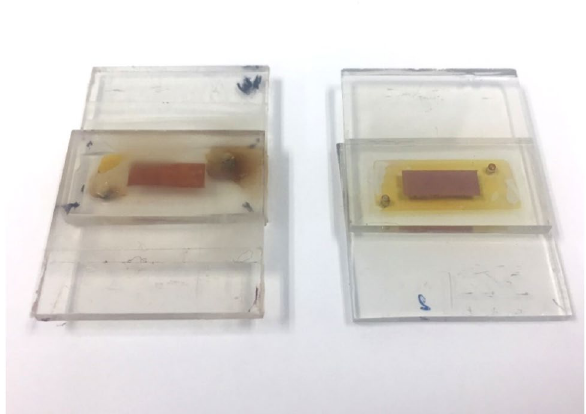
Fig. 13 Photographs of the DSSC devices encapsulated with PU/ PVDC film (left) and with the neat PU film (right), after storage for 14 days. The yellow color represents the Kapton tape, whereas the dark color reflects a discoloration of the PVDC